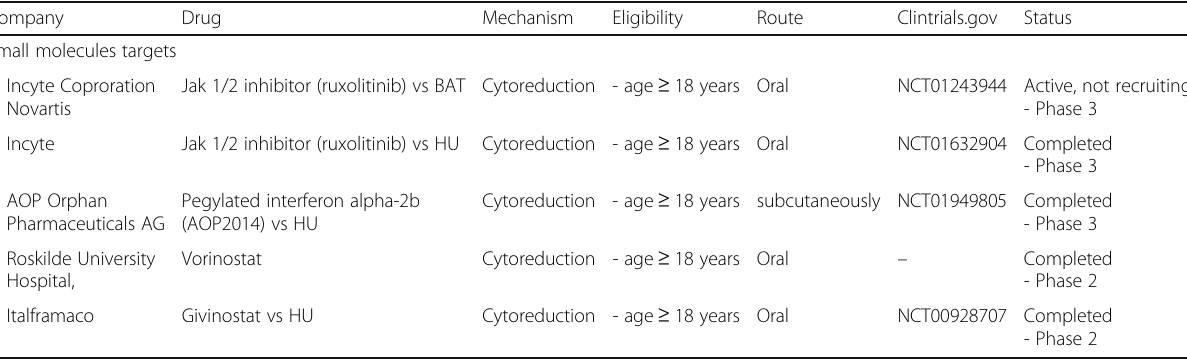
Table 3 Novel therapeutics in Polycythemia Vera